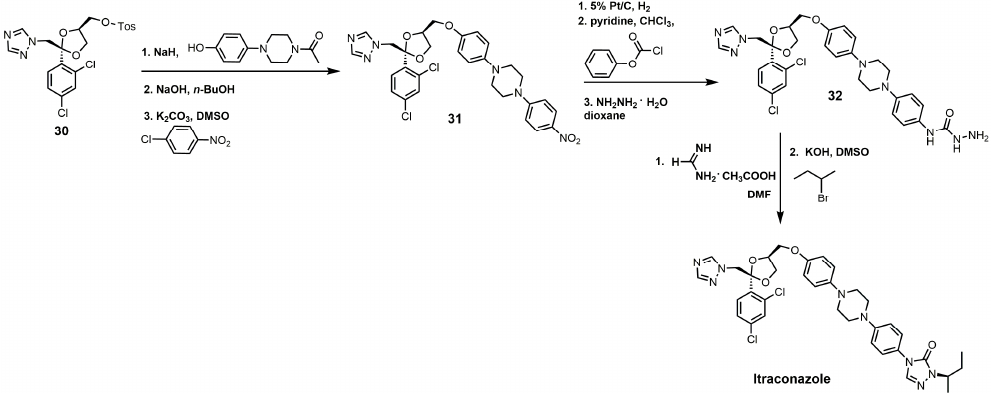
Figure 15. The synthesis of itraconazole.